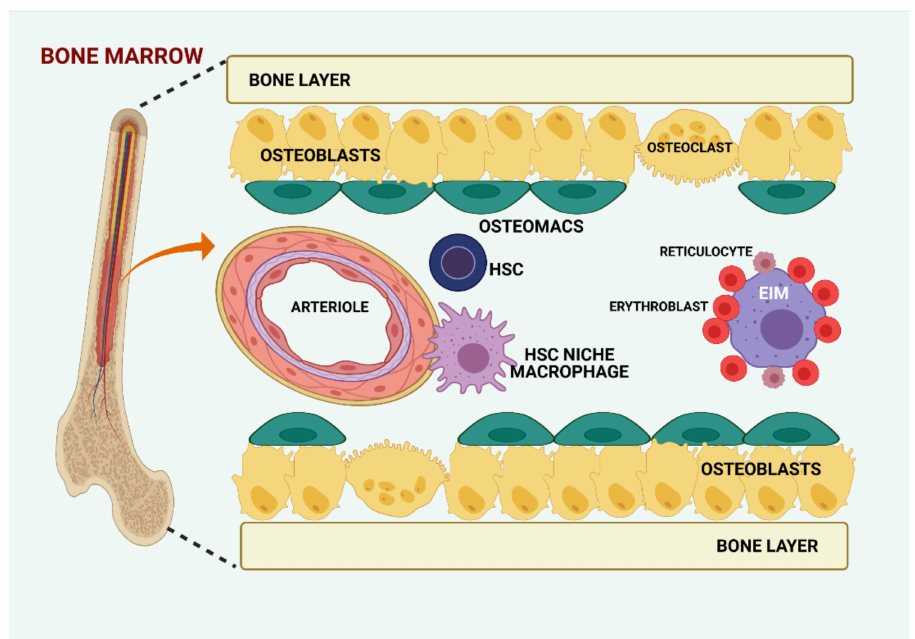
Figure 1. Resident macrophage subsets in bone marrow. There are three resident macrophage subsets in bone and bone marrow: erythroblastic island macrophages (EIM), which interact with erythroblasts and support them during erythropoiesis, hematopoietic stem cell (HSC) niche macrophages, and osteal macrophages (osteomacs). The perivascular niche contains a specific subset of macrophages that support maintenance and proliferation of mesenchymal stem cells and retain HSCs within the bone marrow. Osteomacs can be found immediately adjacent to osteoblasts and regulate bone formation and homeostasis. Created with BioRender.com (accessed on: 7 March